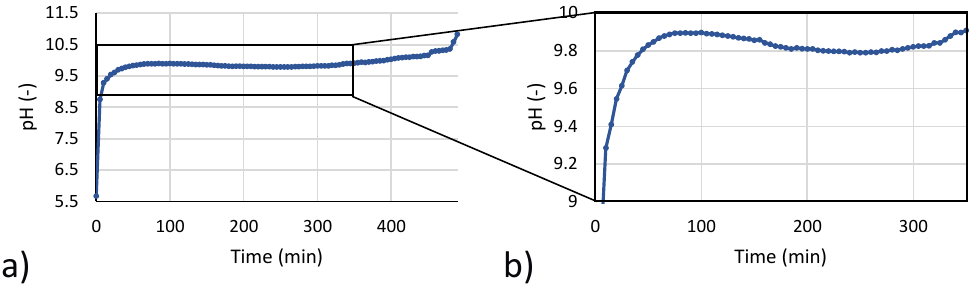
Figure 4. ( a ) pH versus time trend during the start-up phase 4; ( b ) zoom of initial pH vs. time trend.